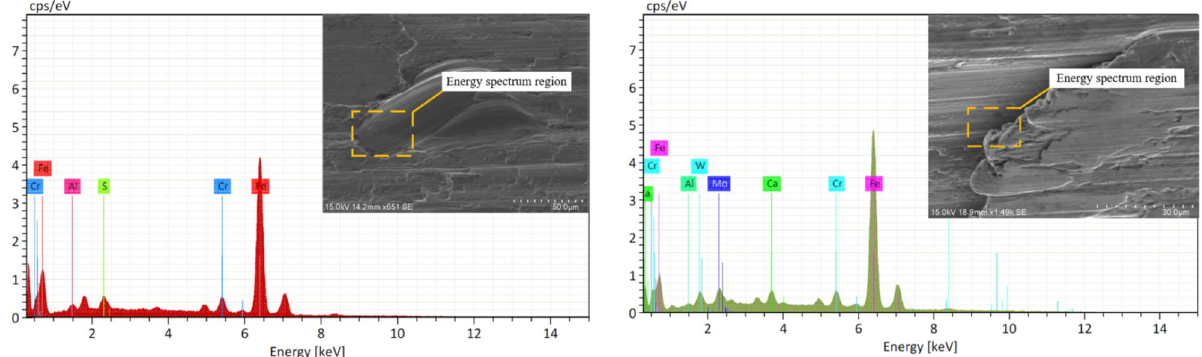
Figure 17 EDS analysis of surface pits and surface coating